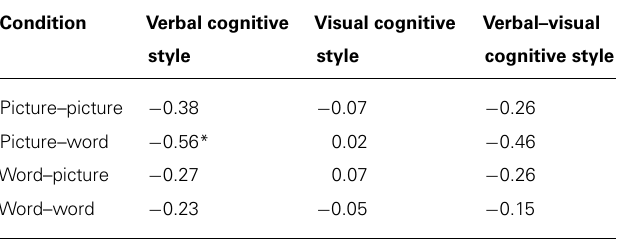
Table 2 | Pearson correlations between cognitive style and accuracy difference scores (SMG session − Vertex session) for each task